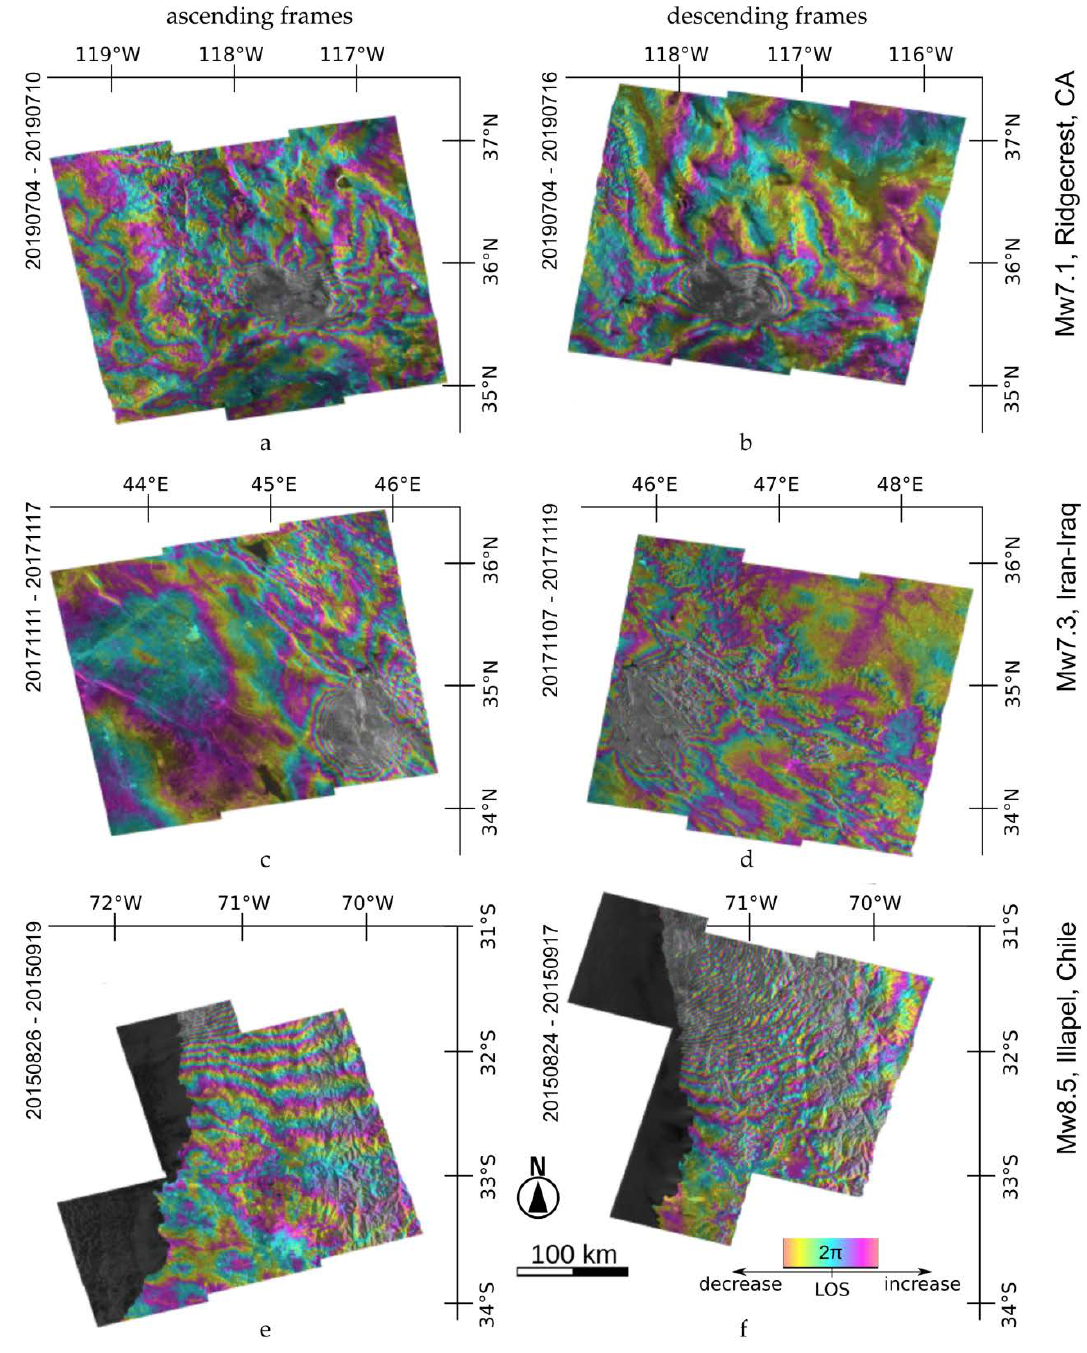
Figure 9. Coseismic interferograms generated in both ascending ( left ) and descending ( right ) orbital tracksofSentinel-1bytheLiCSARprocessorfor: M w 7.1right-lateral, strike-slipearthquakeinRidgecrest, California (4 July 2019) from ( a ) frame 064A_05410_131313 and ( b ) frame 071D_05377_131313; M w 7.3 dip-slip earthquake at the Iran–Iraq border (12 November 2017) from ( c ) frame 072A_05489_131313